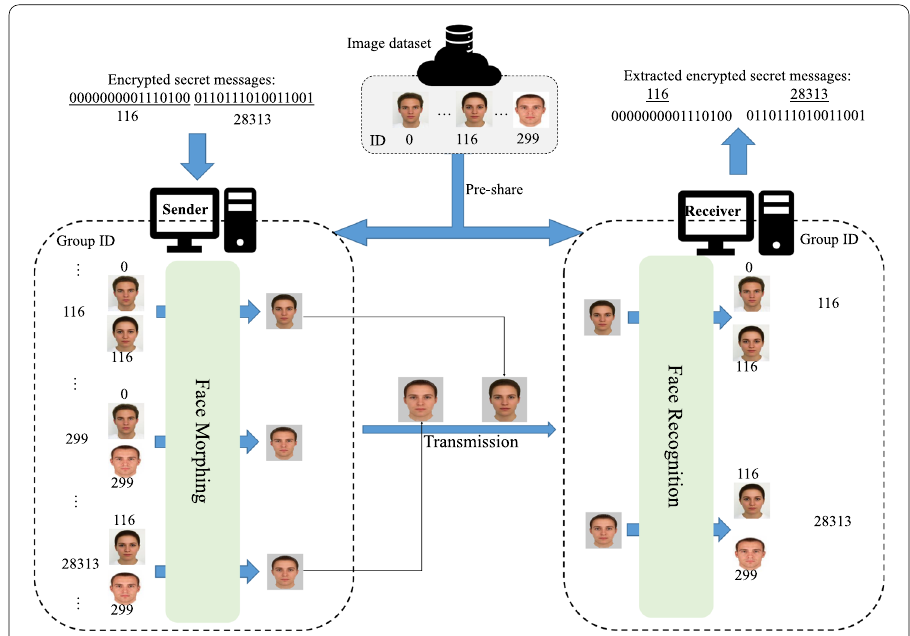
Fig. 10 An example of proposed data hiding scheme. Illustration of the overall process of secret messages embedding, sending, receiving and extraction using the proposed